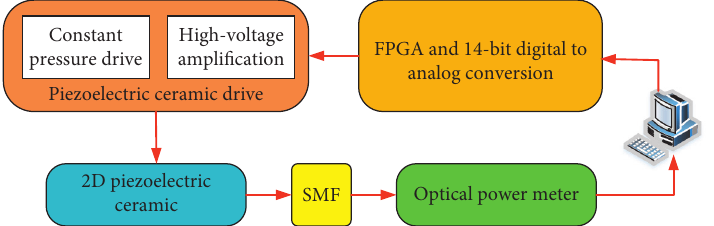
Figure 5: System hardware structure diagram.